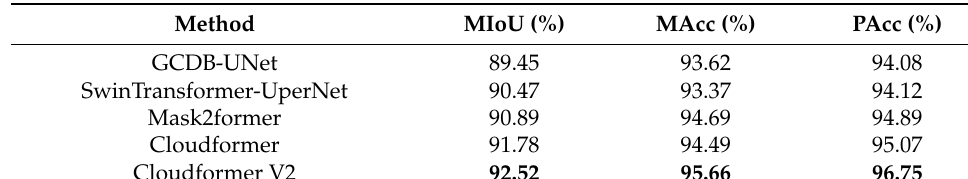
Table 4. Performance Comparison with State-of-the-Art Methods.